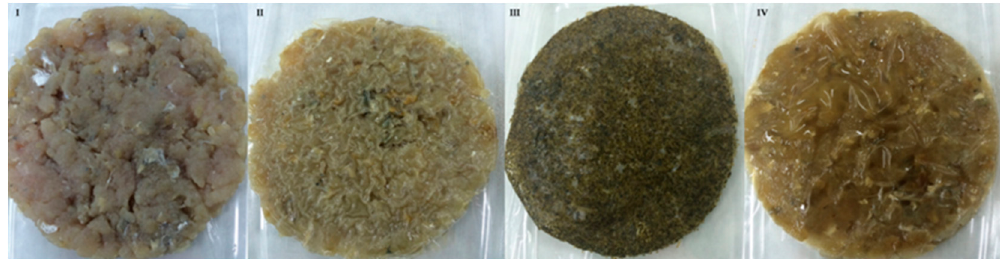
Figure 6. Fish burger from Atlantic horse mackerel coated with different film formulations (control without coating film— I , chitosan— II , sea fennel plant (SFP)— III incorporated in a chitosan-based film and sea fennel extract (SFE) incorporated in a chitosan-based film— IV ).